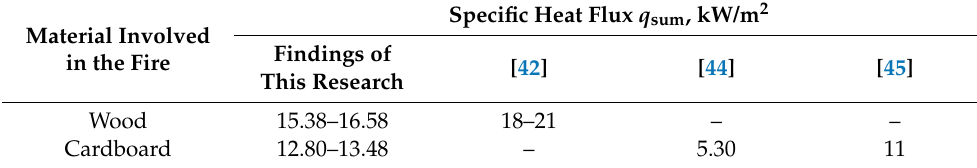
Table 5. Specific heat